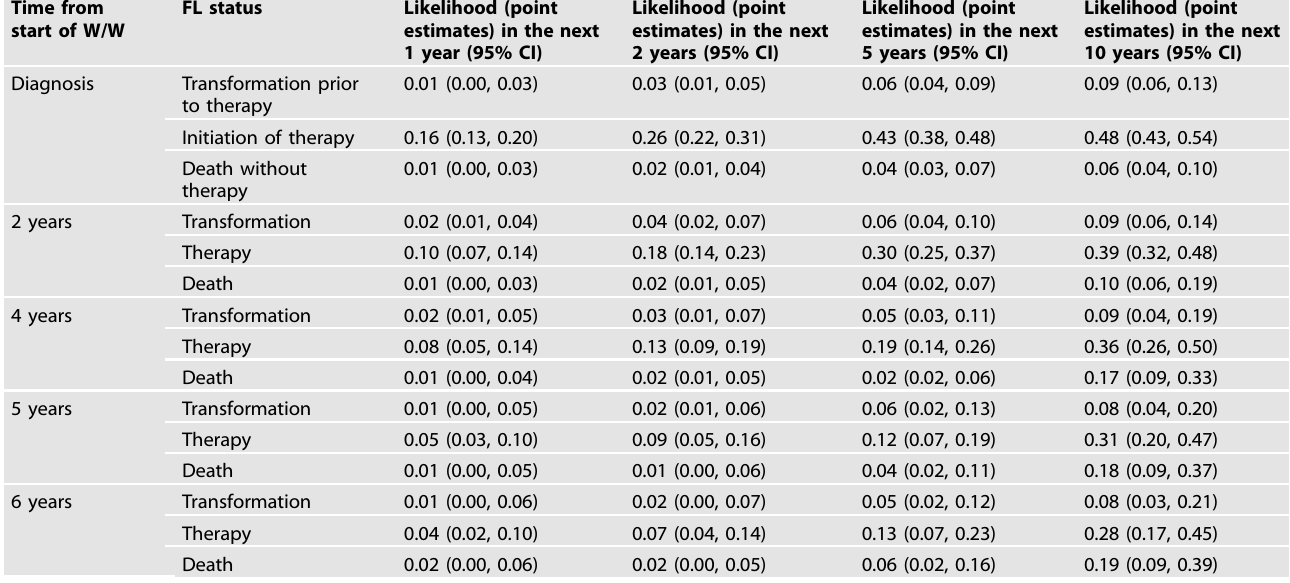
Table 2. Cumulative incidence estimates of treatment initiation, transformation to DLBCL before treatment, and death without therapy based on the duration of W/W